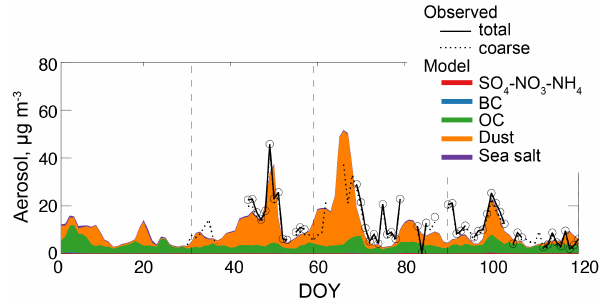
Figure 9. Time series of observed and simulated aerosol concentra- tions at ATTO during January–April 2014. Observed total aerosol concentrations are the sum of coarse aerosol ( d p >1µm) from OPS and fine aerosol ( d p ≤ 1µm) from SMPS. Model results are sepa- rated into different species. Vertical dashed lines indicate the end of each month.